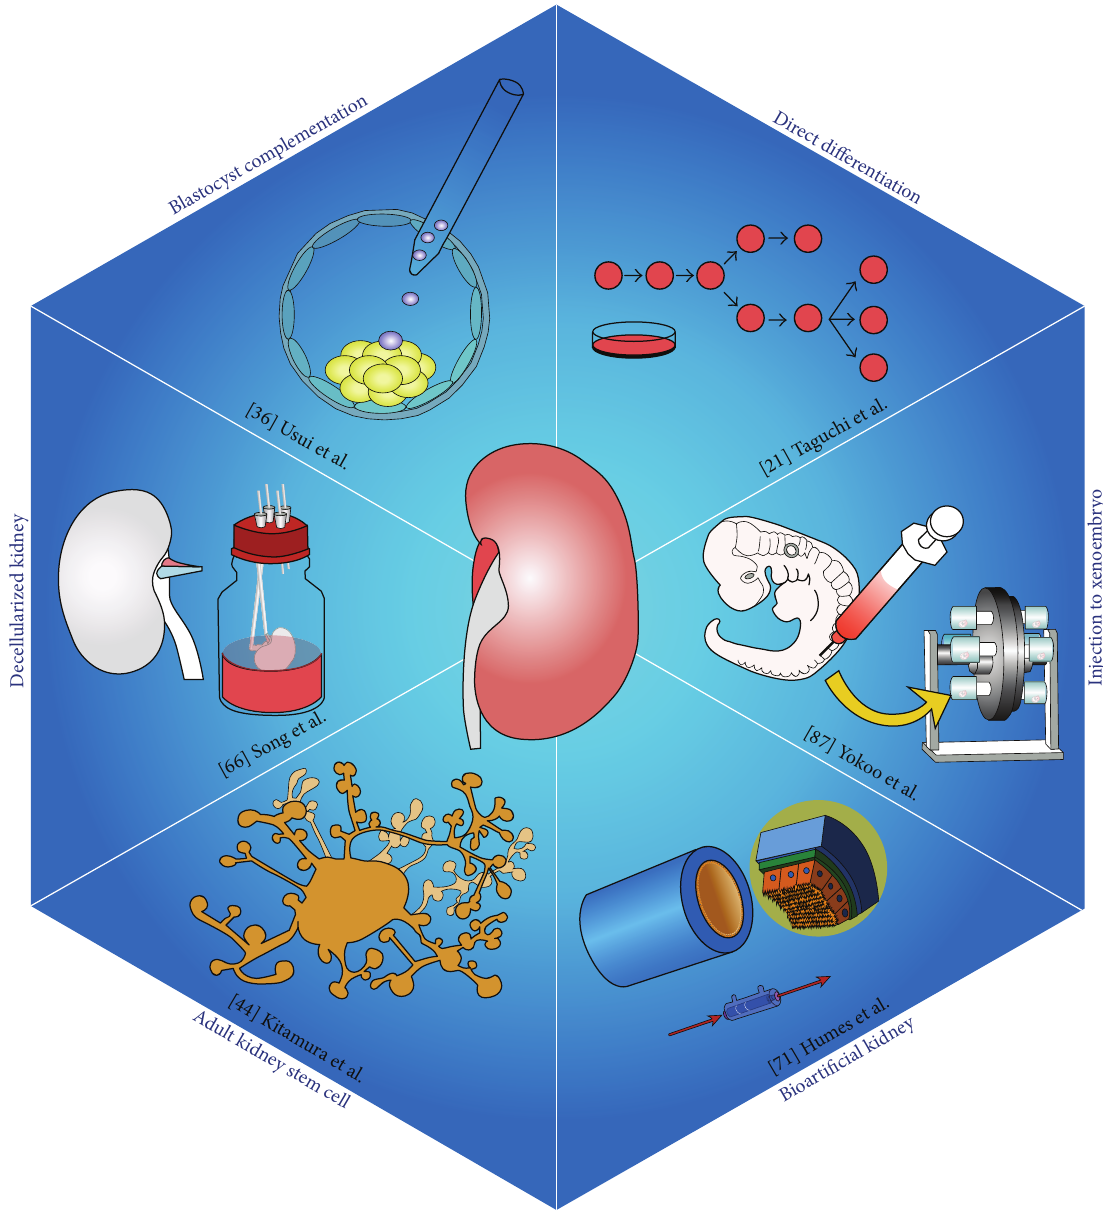
Figure 1: Schematic representation of the main strategies for kidney